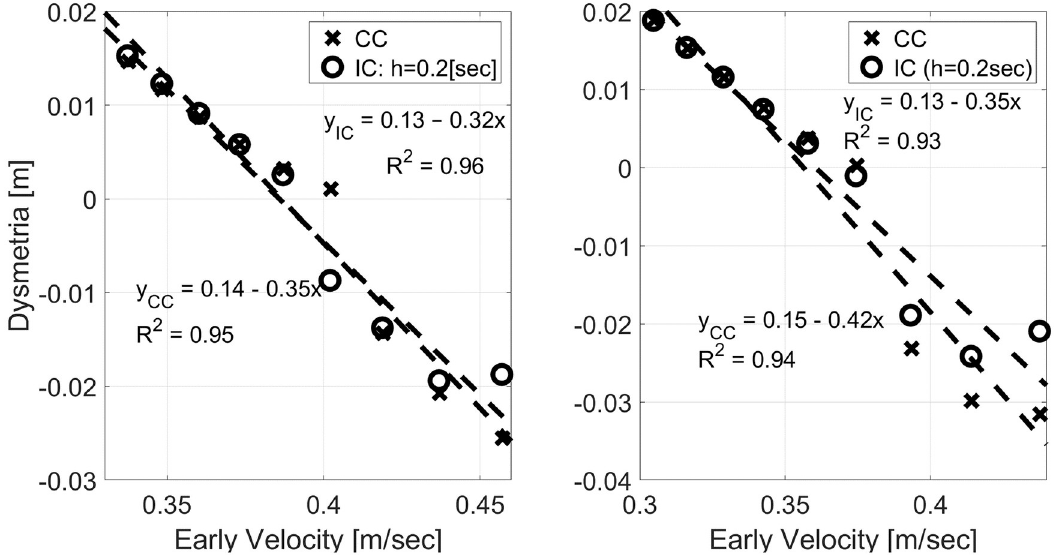
Fig 9. Dysmetria versus early velocity from simulations with inaccurate mass and modified cost function when m IM = 2[Kg] (left) and m = 4[Kg] (right). All simulations were conducted with τ = 0.15[sec] and Q 1 = diag (1, 0.1 2 , 0.02 2 , 0) instead of the IM nominal Q 1 = diag (1, 0.2 2 , 0.02 2 , 0). IC was conducted with h = 0.2[sec]. Left: m PL = (1.5, 2.5)[Kg] evenly spaced around m IM = 2 [Kg]. Right: m PL = (3, 5)[Kg] evenly spaced around m IM =